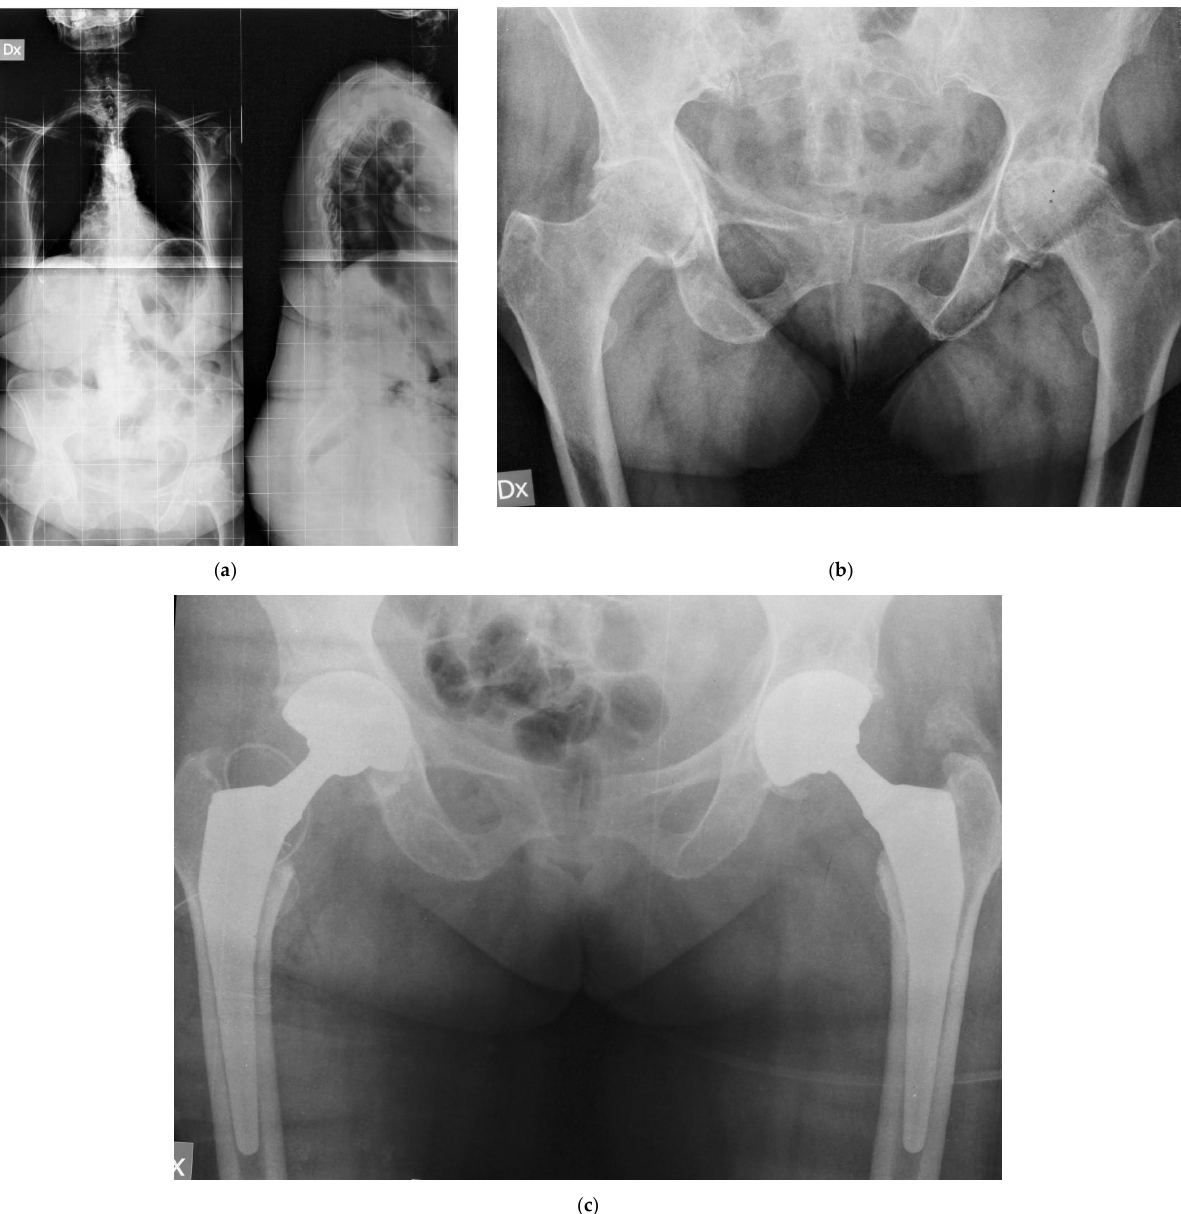
Figure 3. steno-instability and consequent sagittal imbalance oh the spine ( a ); severe bilateral hip osteoarthritis ( b ); staged bilateral total hip replacements using DM modular cups and cementless stems ( c ).